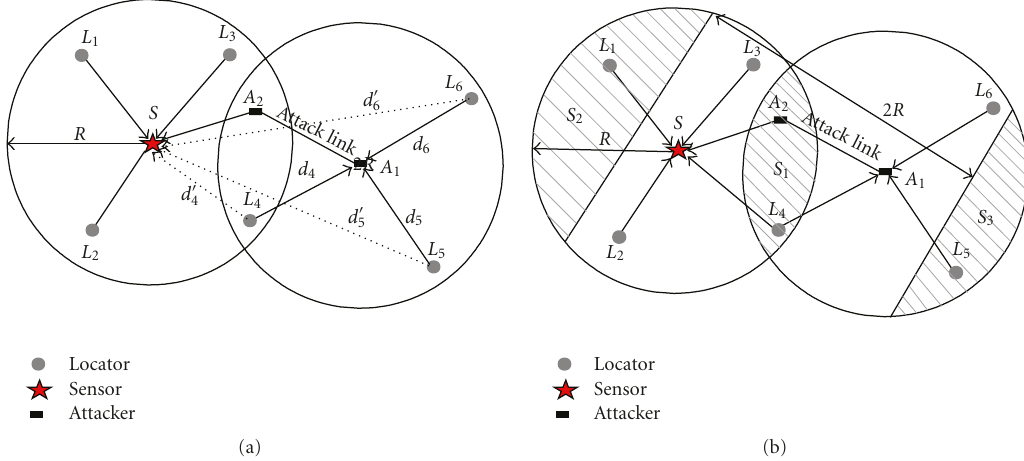
Figure 1: The attack scenarios in WSN. (a) Attacker model in range-based localization; (b) Attacked locators with temporal and spatial